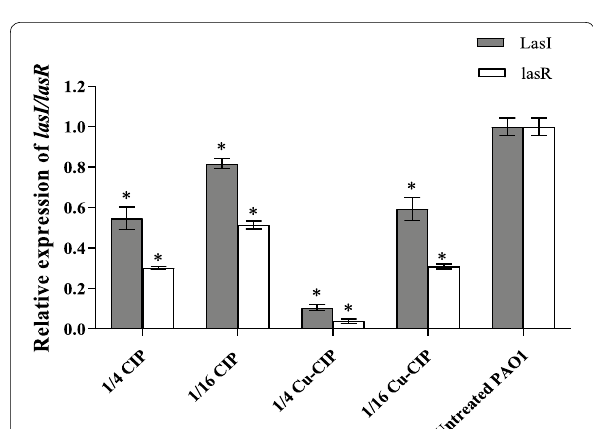
Fig. 6 The subinhibitory concentrations (1/4 and 1/16 MIC) of ciprofloxacin (CIP) and copper-ciprofloxacin complex (Cu-CIP) inhibited QS regulated genes in treated PAO1 (*, significant, P <